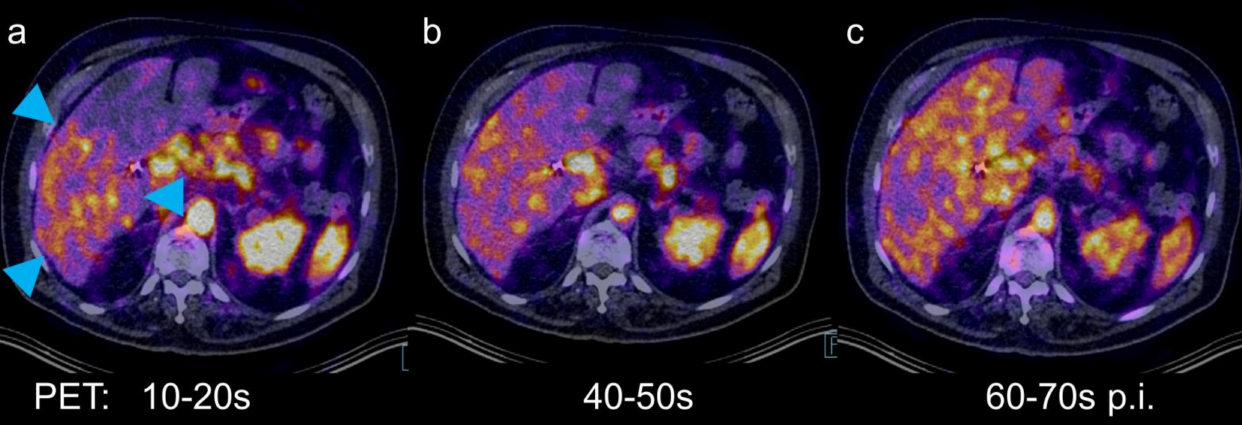
Figure 2. Positron emission tomography (PET)/CT has dynamic imaging capabilities for the depiction of liver tumors [3]. Therefore, an examination with the hepatobiliary tracer [68Ga]Ga-tri-methoxysalicyl-(TMoS)-DAZA was performed. Similar to mebrofenin derivatives and liver-specific MR contrast agents (e.g., gadoxetic acid), this 1,4-diazepan-6-amine (DAZA) ligand is extracted from the blood by hepatocytes and secreted into the bile [4–6]. In this case, 155 MBq of the tracer were injected intravenously. A dynamic PET of the liver over 3 min was acquired and reconstructed in 10-s timeframes. Early arterial hyperperfusion was evident in the region of the tumor ( a , arrowheads). Tumor uptake was equal to normal liver 50 s after injection ( b ). From 60 s after injection, uptake in the tumor was lower than in the surrounding liver tissue ( c